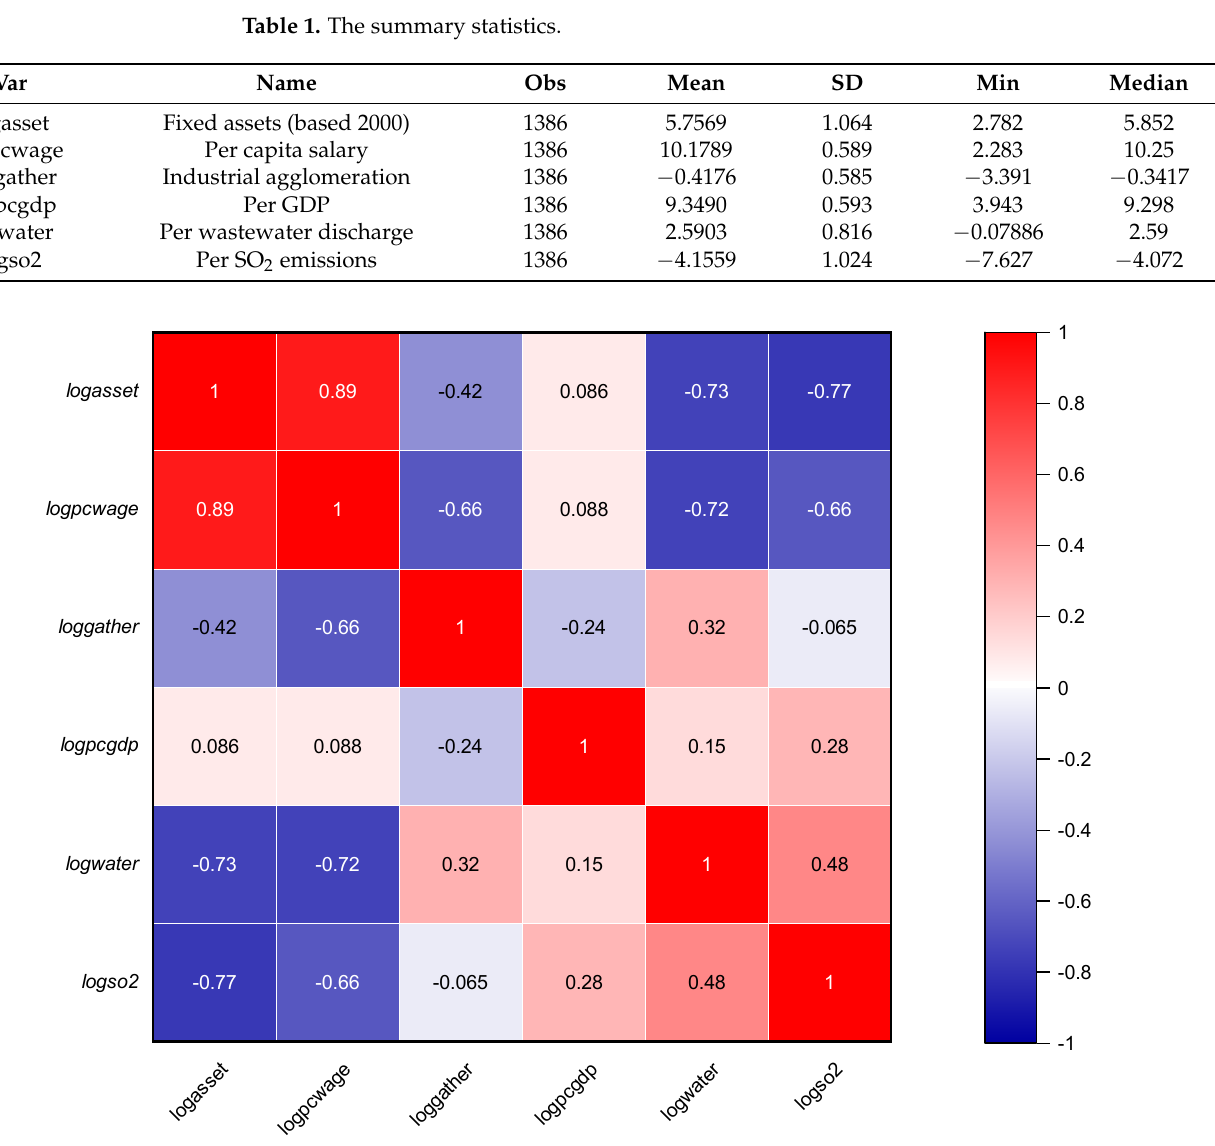
Figure 1. Correlation coefficient Note: Lower-triangular cells report Pearson’s correlation coefficients, upper-triangular cells are Spearman’s rank correlation.